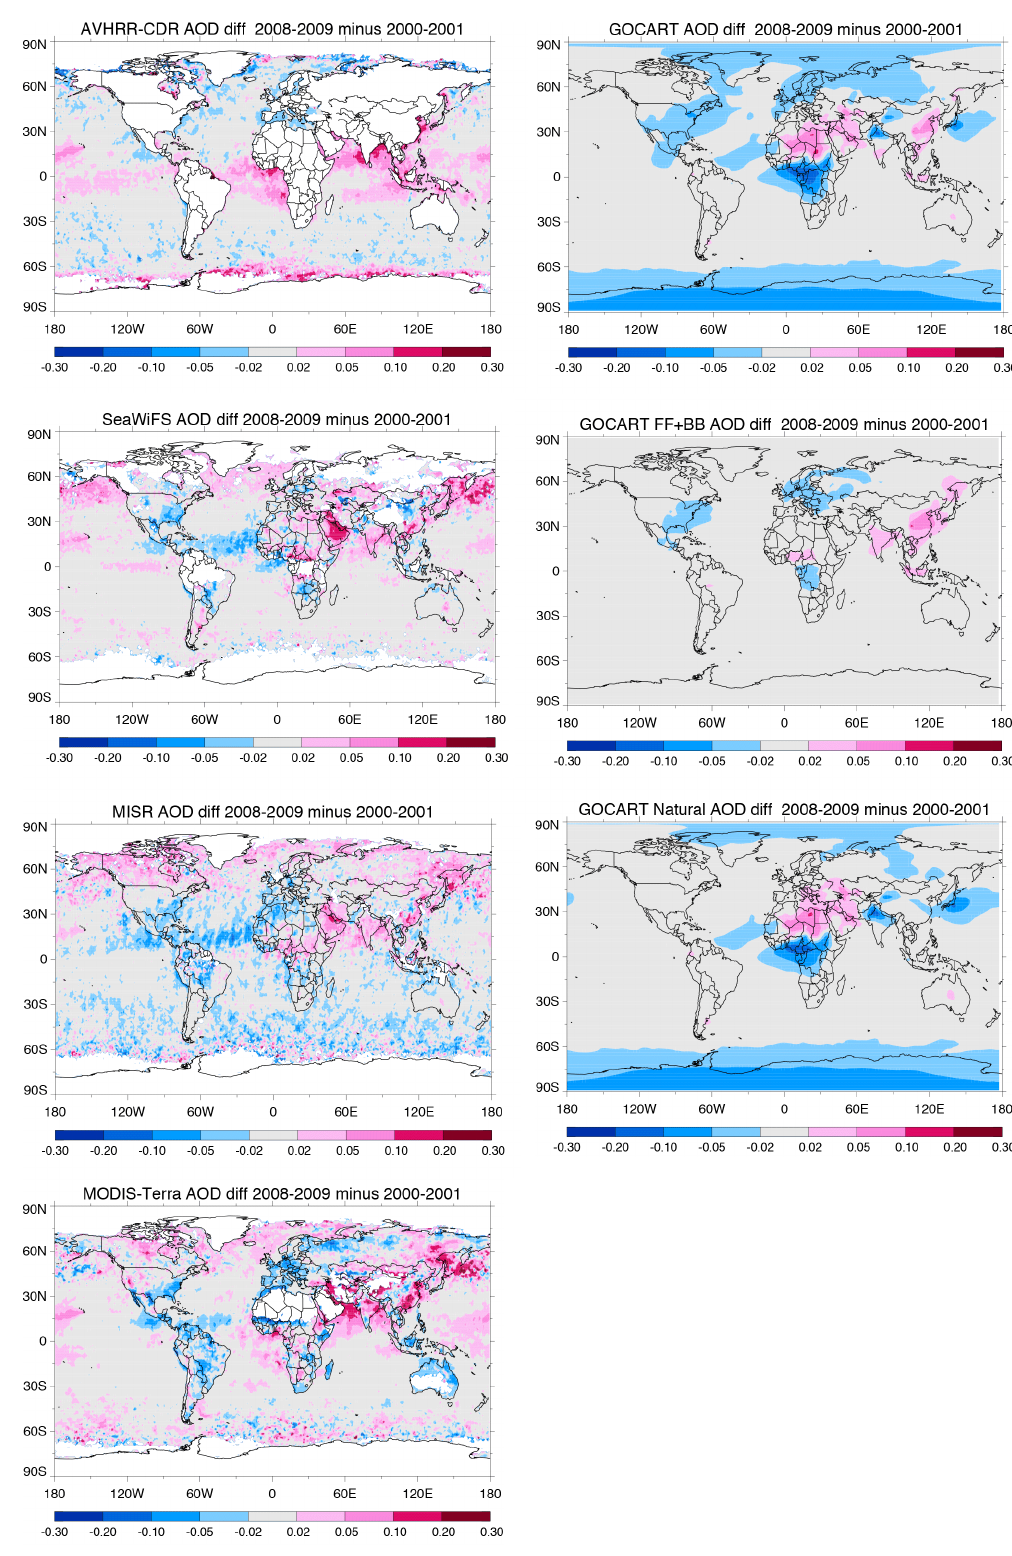
Fig. 11b. Difference of AOD between 2008–2009 and 2000–2001 from satellite data (left column, from top: AVHRR-CDR, SeaWiFS, MISR, and MODIS-Terra) and GOCART simulations (right column, from top: total, FF + BB, and natural AOD). White area indicates no data. The data gap over the desert regions in MODIS-Terra is due to the unavailability of Deep Blue products in 2008 and 2009.